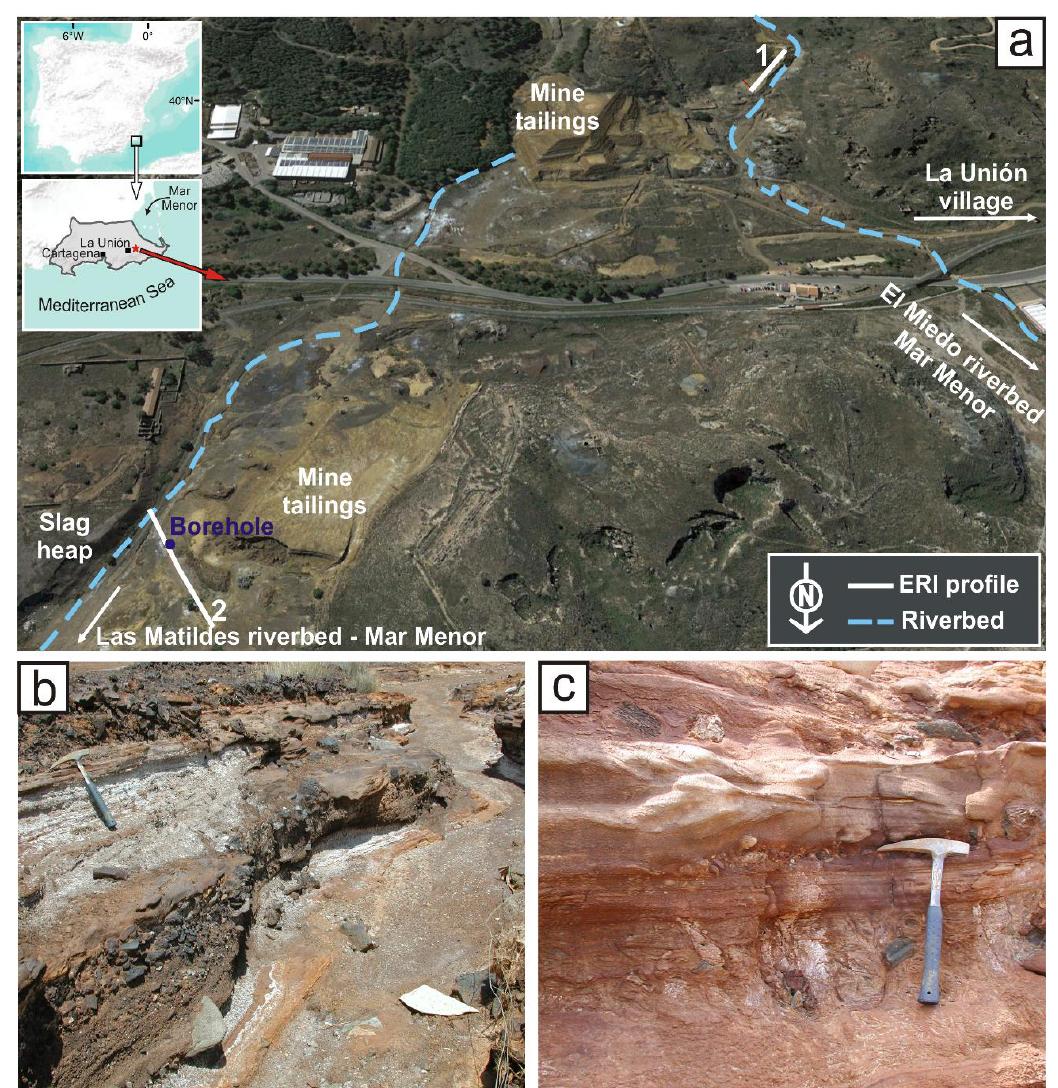
Figure 1. ( a ) Location of the Cartagena–La Unión mine district, the geophysical surveys, and the sampling points; ( b ) mine tailings and metallurgical slag, mixed with riverbed sediments in the Las Matildes riverbed; ( c ) remaining medium-to-fine-grained mine tailings deposits, showing embedded metamorphic bedrock fragments.